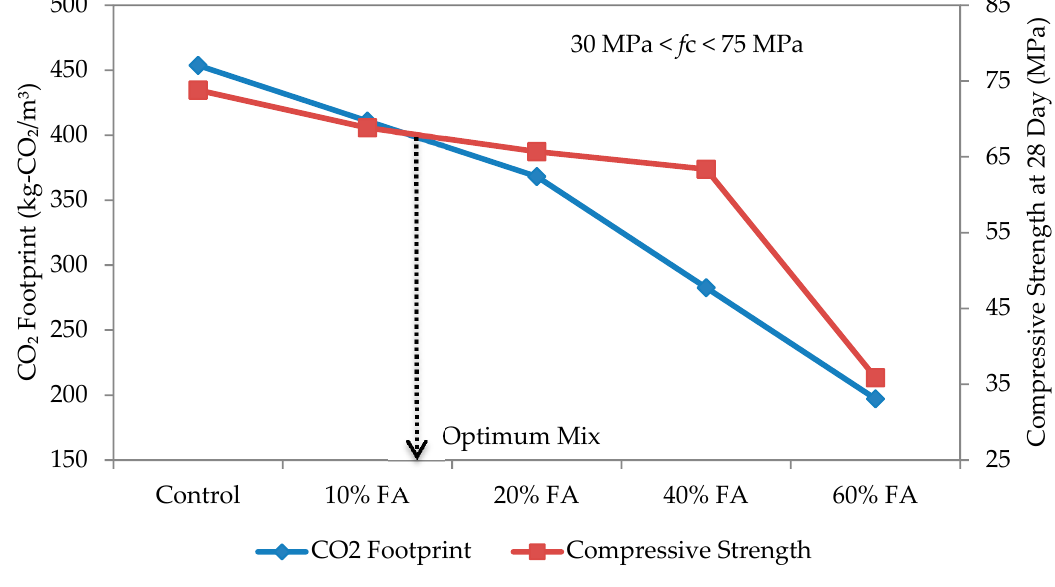
Figure 15. Optimum mix for self-compacting mortar at w/b 0.40.